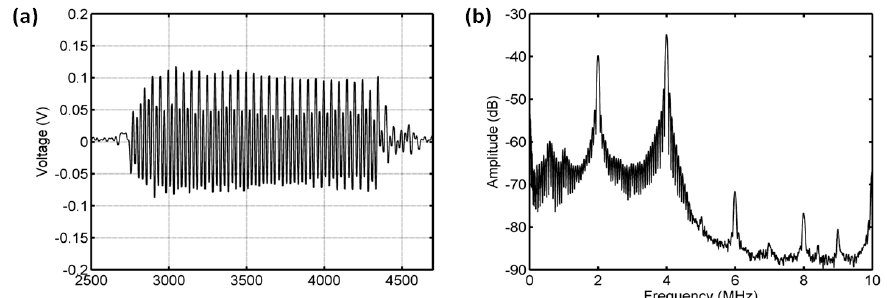
Figure 9. The measured scattering signals from microbubbles and the averaged power spectrum of 50 received signals. ( a ) A single received signal, ( b ) the averaged power spectrum. The driving frequency was 4 MHz, the acoustic pressure was 350 kPa, and the overpressure was 180 mmHg.